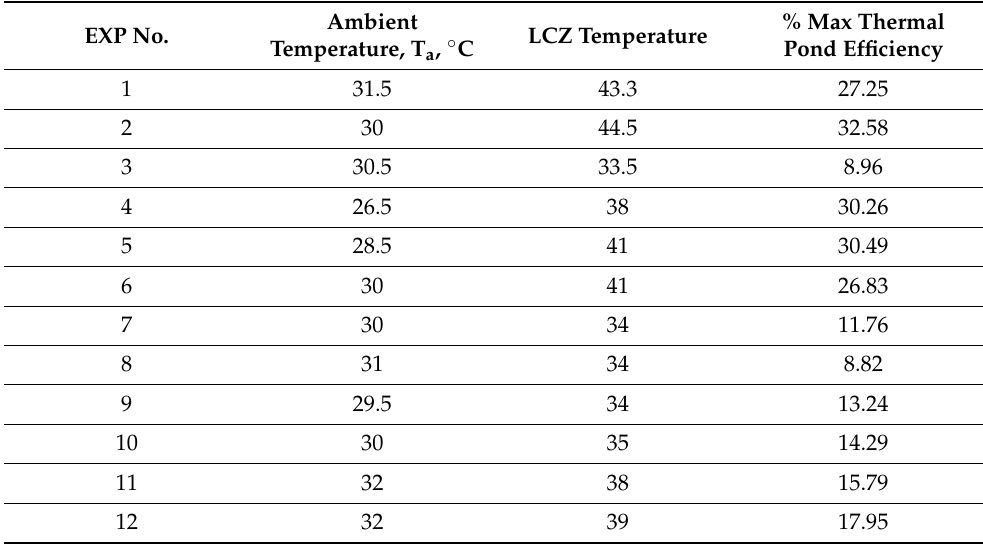
Table 3. % Maximum thermal pond efficiencies for carried-out experiments according to conditions of Table